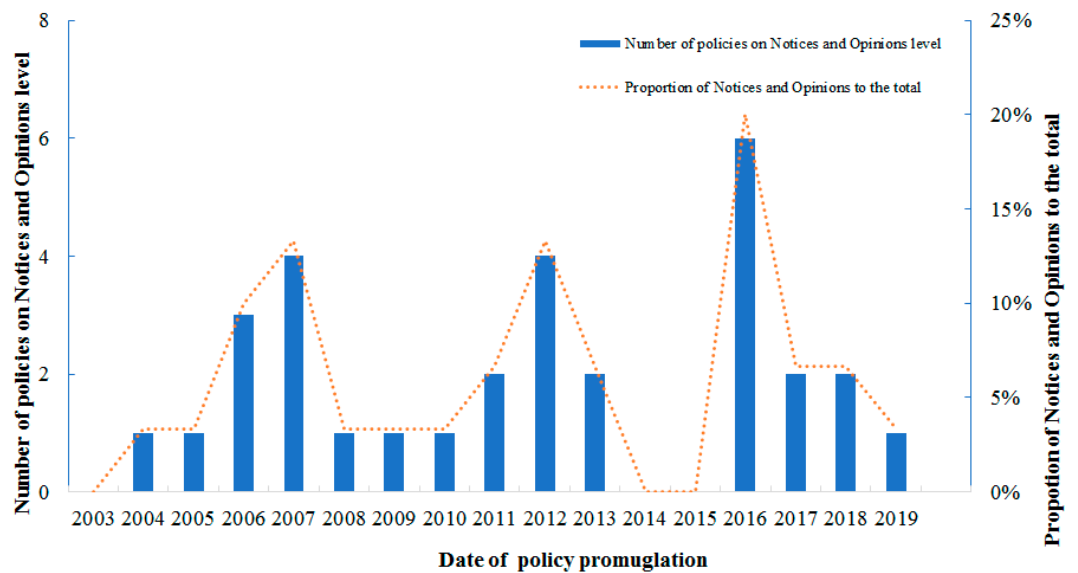
Figure 3. Changes in the number and proportion of relevant policies.